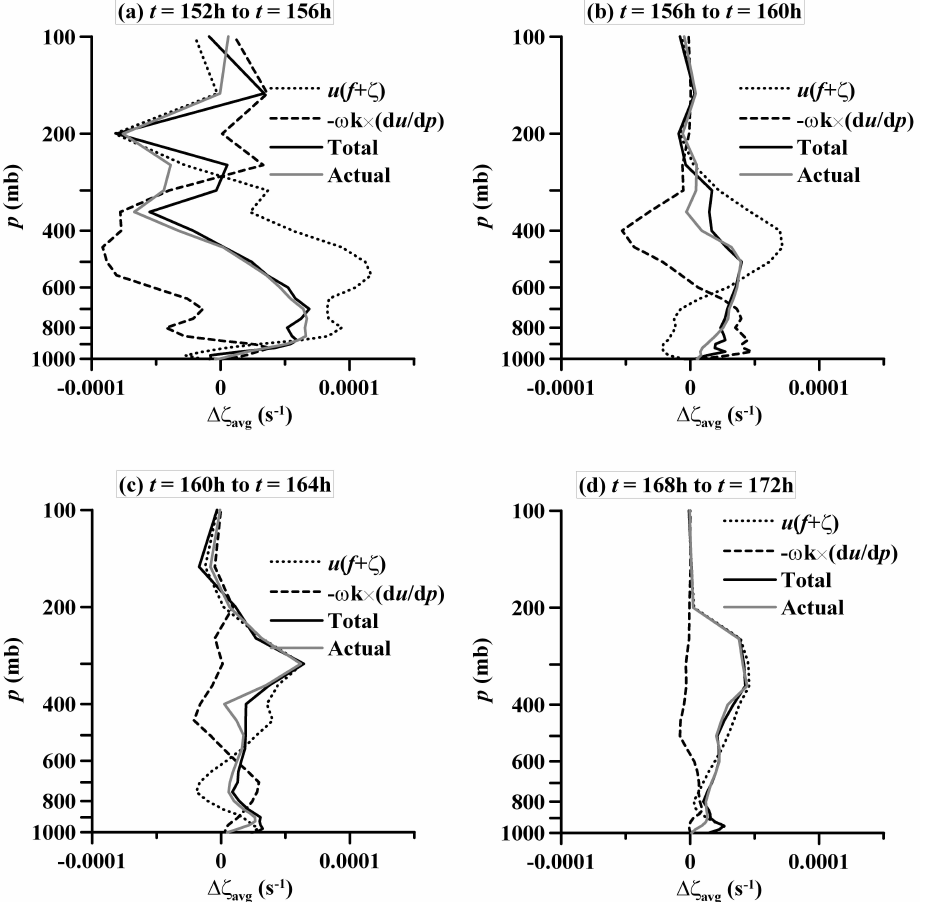
Fig. 4. Circulation budget analysis expressed as area average vorticity change for a rectangle surrounding the vortex on the 3.3-km grid in the CAPE simulation. The time periods are as follows: (a) 152h to 156h; (b) 156h to 160h; (c) 160h to 164h; and (d) 168h to 172h, respectively. For notation, see Fig.